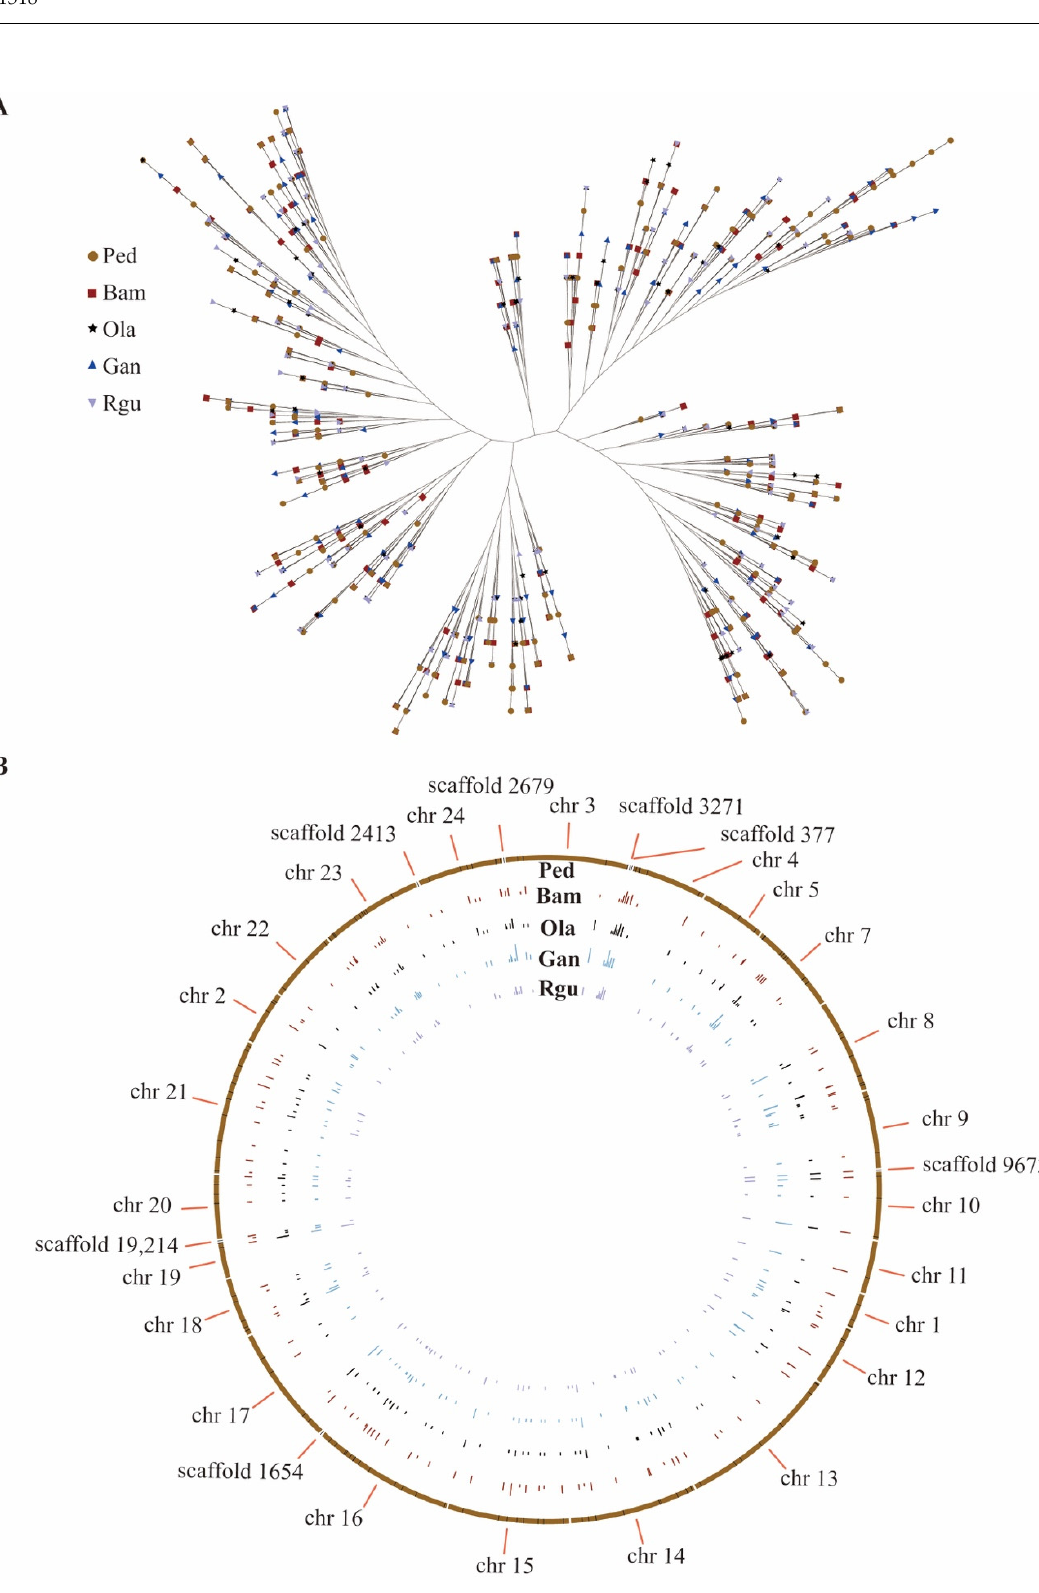
Figure 4. Phylogenetic relationship and chromosome distribution analyses of orthologous peroxidase gene pairs between P. edulis (Ped) and the other four bamboo species of B. amplexicaulis (Bam), G. angustifolia (Gan), O. latifolia (Ola), and R. guianensis (Rgu). ( A ) Phylogenetic tree constructed using the peroxidase from five bamboo species. ( B ) Statistical chromosome distribution of orthologous peroxidase gene pairs between P. edulis and the other four bamboo species respectively. In addition, the selection types and divergence time of the analyzed orthologous and paralogous peroxidase gene pairs were calculated according to the nonsynonymous